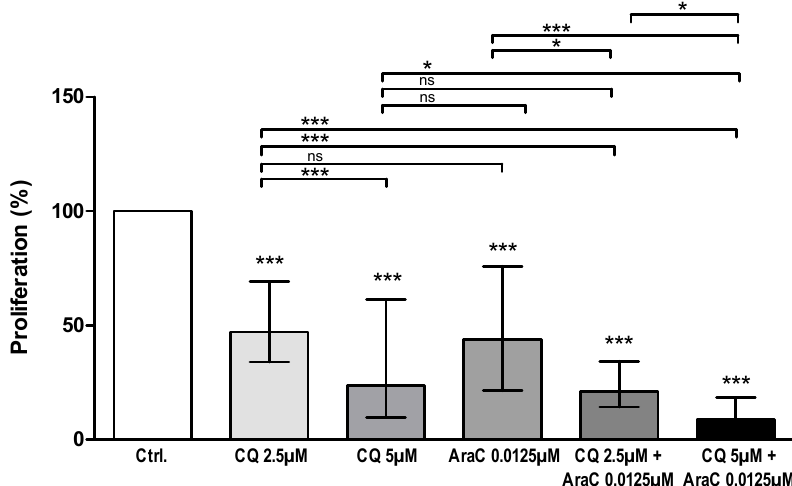
Figure 2. Effect of chloroquine (CQ) alone or in combination with cytarabine (AraC) on cytokine- dependent AML cell proliferation. AML cells from 81 consecutive patients were cultured for seven days in medium alone (control cultures) or treated with CQ (2.5 and 5 µ M), cytarabine/AraC (0.0125 µ M) or CQ in combination with cytarabine/AraC. The 3H–thymidine assay was used to measure cell proliferation. Detectable proliferation defined as > 1000 cpm in untreated control cultures, was observed for 69 patients. Proliferation is shown as the median levels (with 25–75% percentiles), and proliferation in treated cultures is shown as percent proliferation of the drug-free controls (set to 100%). Significant effects were calculated using Mann–Whitney U-test for comparisons between drug-containing and drug-free controls (shown as asterisks above bars), and Kruskal–Wallis with Dunn’s post hoc test for comparison between the different groups (asterisks above brackets) (ns = not significant, * p -value = 0.05, *** p -value = 0.0001).